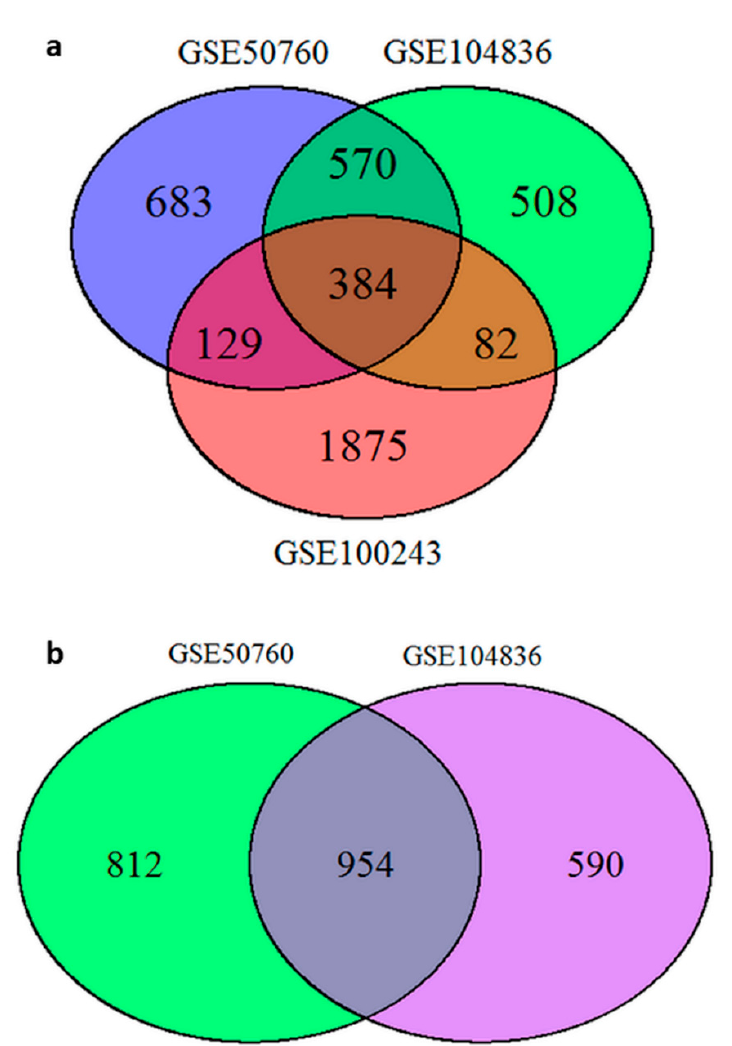
Figure 1. Venn diagrams of overlapping differentially expressed genes: ( a ) overlap between projects GSE50760 (blue color), GSE104836 (green color), and GSE100243 (red color); ( b ) overlap between project GSE50760 (green color) and GSE104836 (violet color). Legend: GSE: gene expression omnibus series.